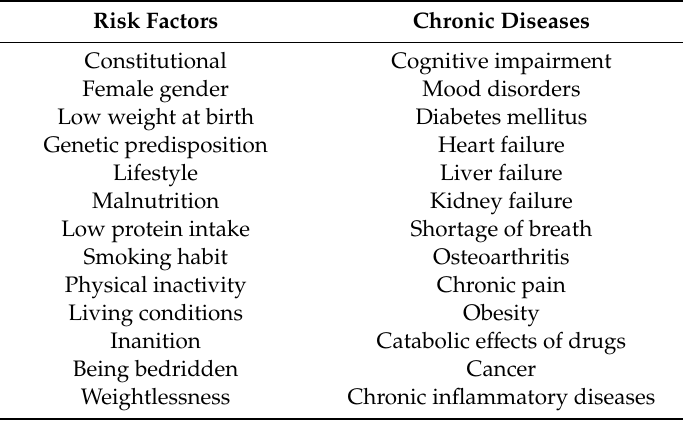
Table 1. Risk factors associated with sarcopenia